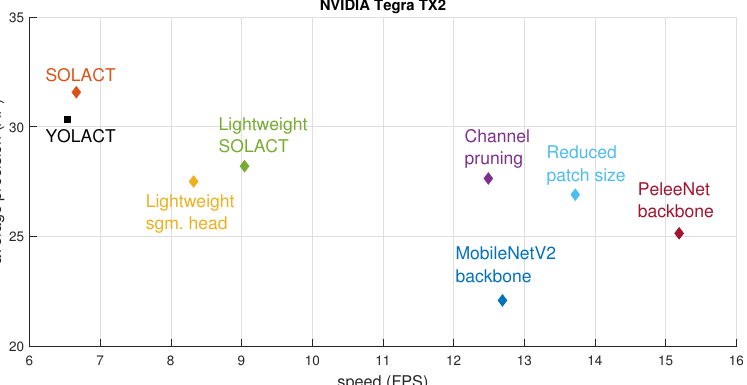
Figure 11. Speed-vs.-performance trade-off, where the models are deployed on the NVIDIA Tegra TX2 [8].